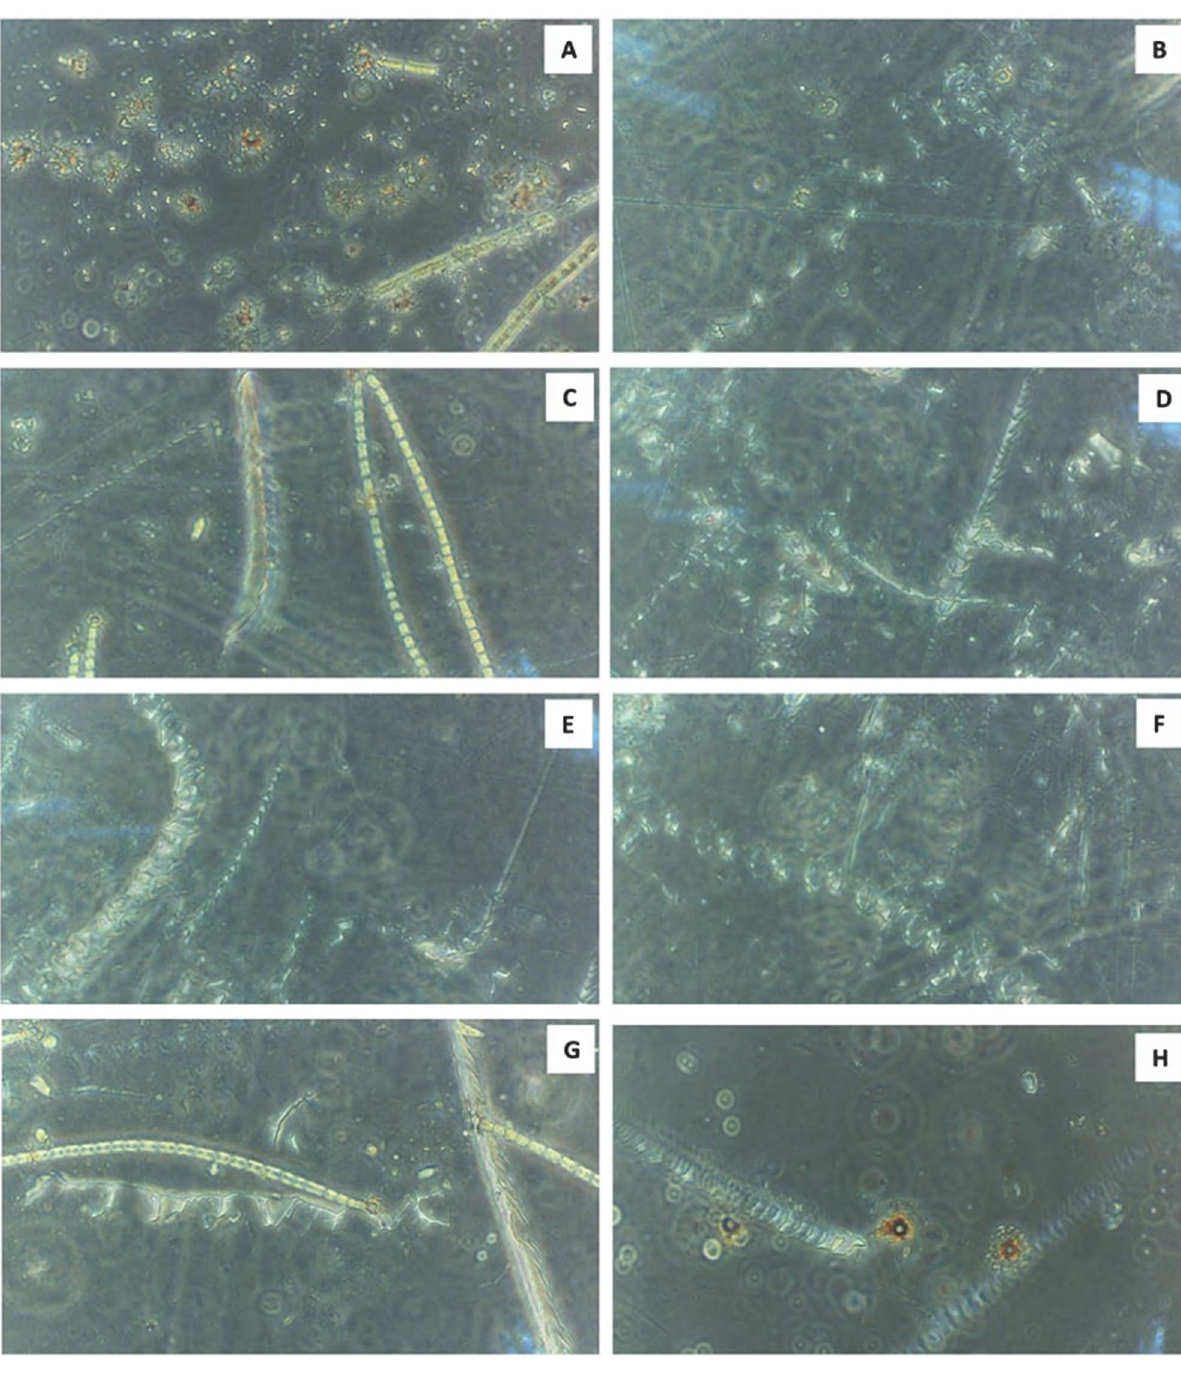
Figure 12. ( A – H ) The × 40 magnification of dark field microscopic images clearly indicates the presence of erosions on LDPE sheet due to the formation of radial disc by microalga followed by abrasions, ridges and grooves formed by the filaments of microalga U. africanum